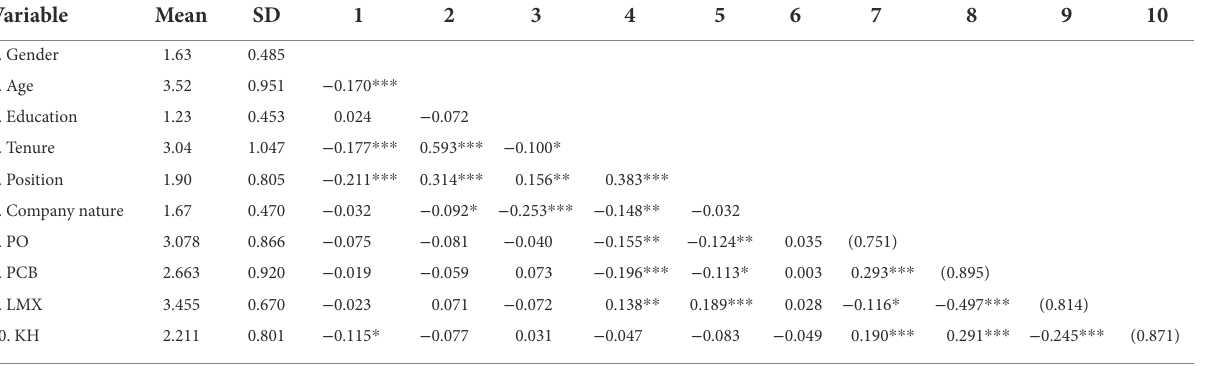
TABLE 5 Means, standard deviations, and correlations ( N =